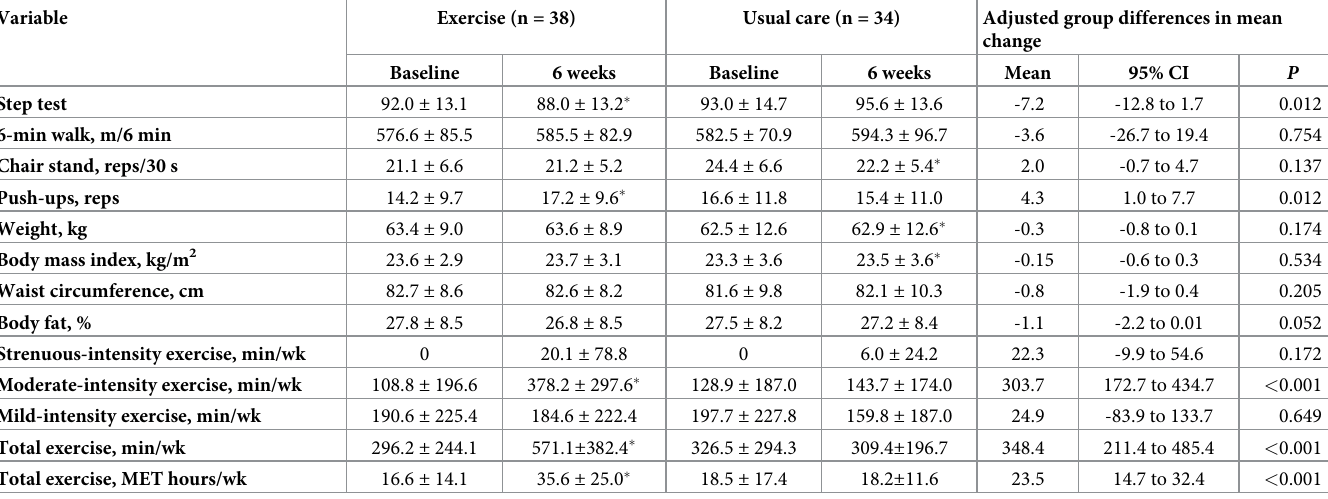
Table 2. Changes in physical fitness, body composition, and physical activity level in the exercise and usual care groups (n =